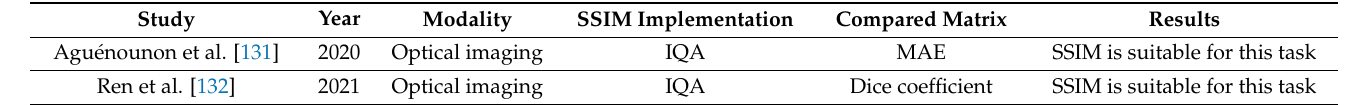
Table 5. Summary of the published articles encompassing SSIM for optical imaging. MAE, mean-